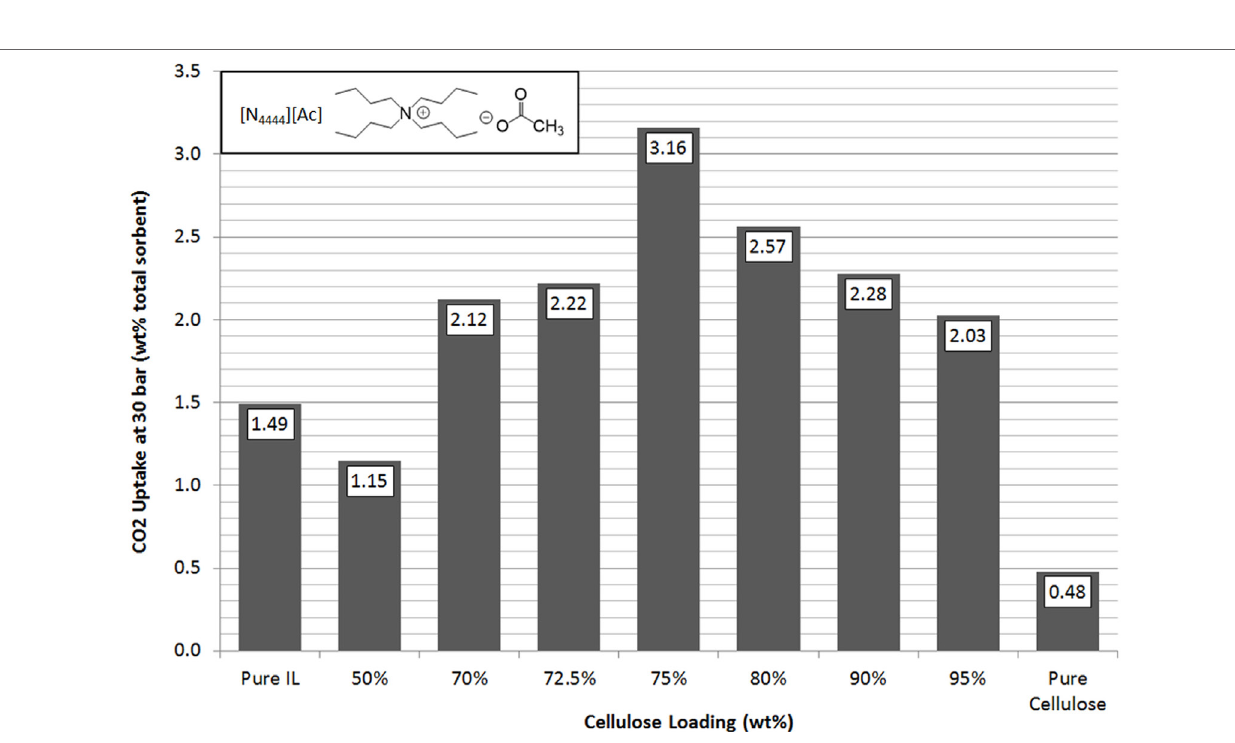
FigUre 5 | Trends in total sorbent CO 2 uptake at 30 bar of [N 4444 ][Ac] as a function of cellulose loading at room